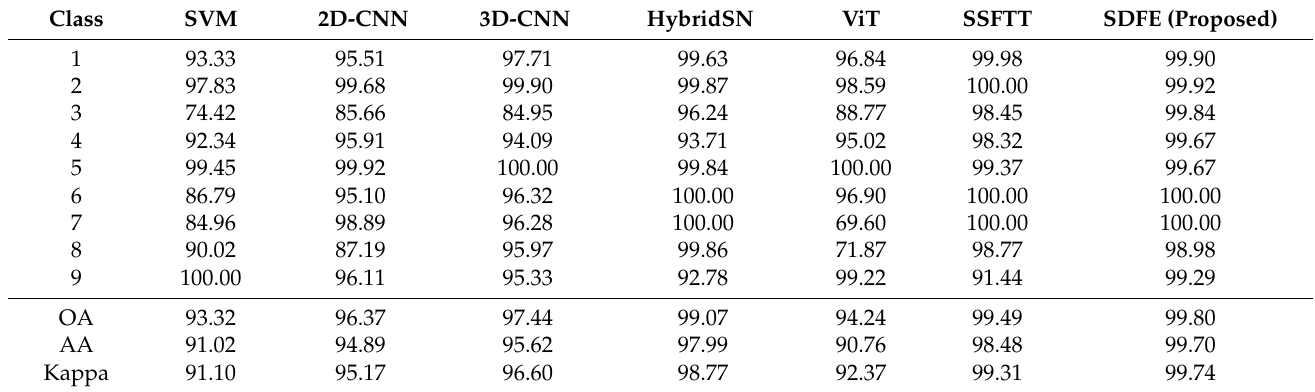
Table 11. The classification results (in percent) using SDFE and other baselines for the PU dataset.